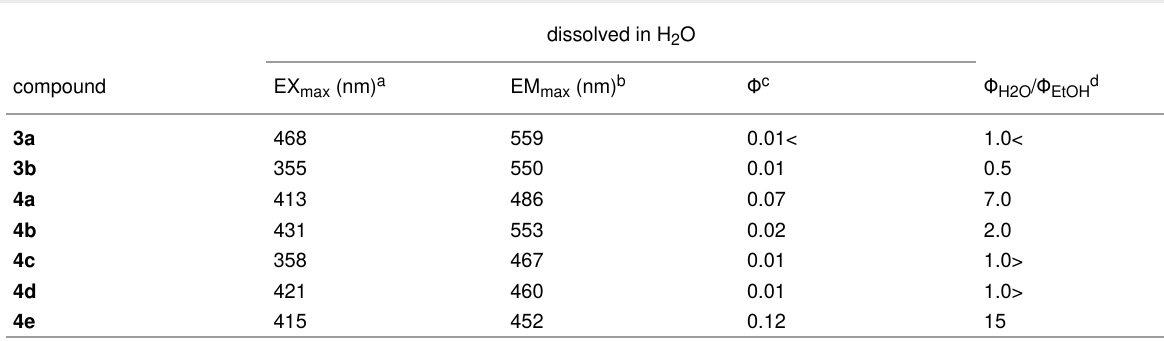
Table 3: Fluorescence data for 3a , b , and 4a – e in H 2